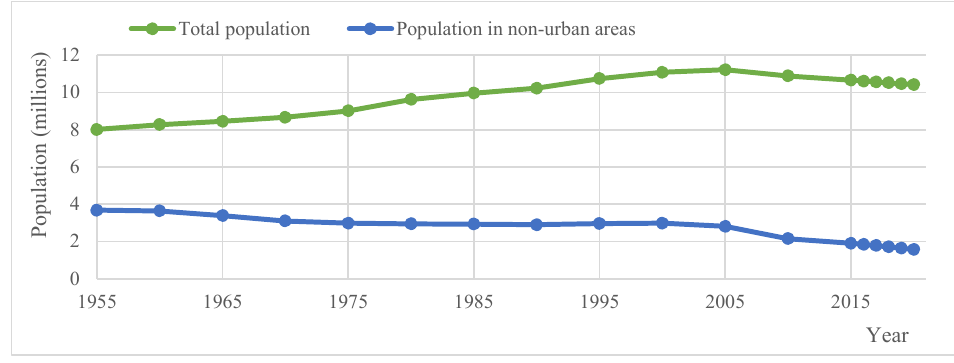
Figure 22. Total population of Greece and population in non ‐ urban areas 1955–2019 [119].